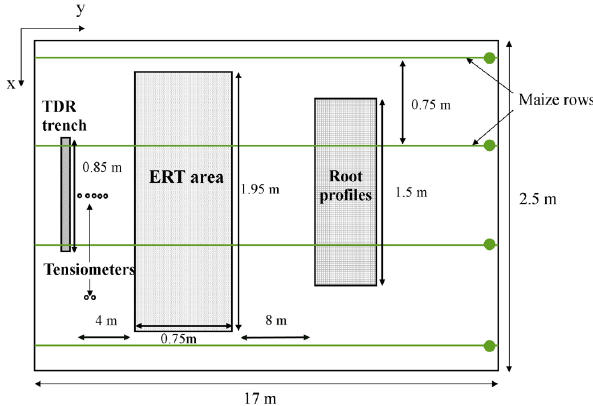
Fig. 2. Scheme of the experimental plot, with position of the TDR trench containing the 14 TDR probes, ERT area with the ERT elec- trodes, tensiometers and place where the root profiles were made. The green lines represent the maize